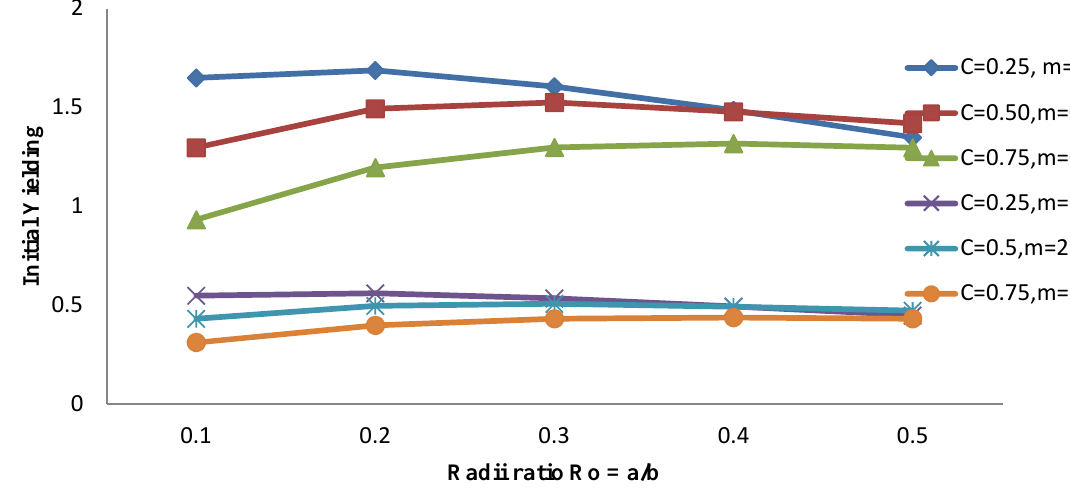
Figure2.Angular Speed required for initial yielding for various radii ratios G with the effect of variable density parameter ( m = 0,